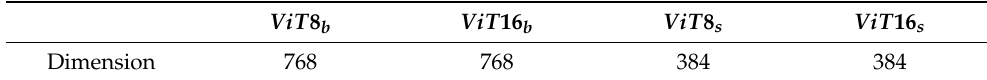
Table 1. Dimensions of the four ViT